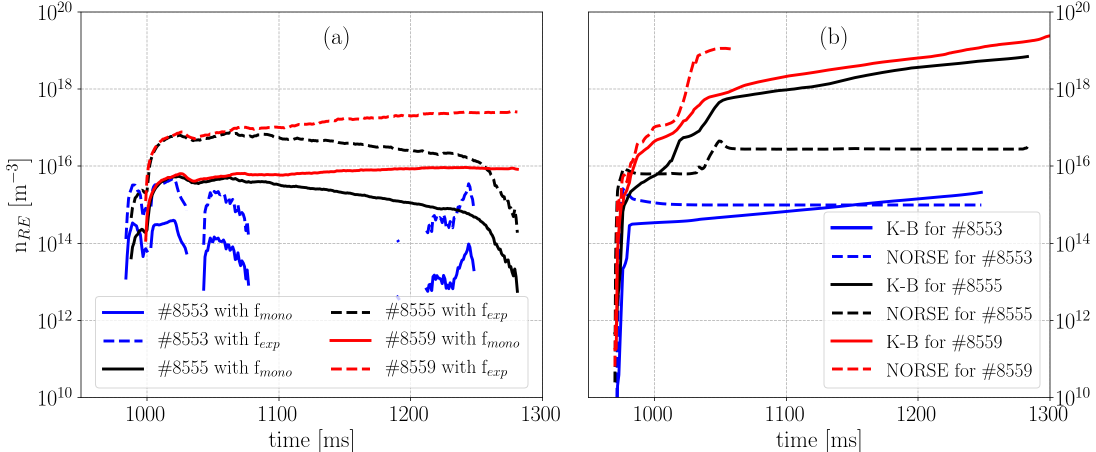
Figure 4. Time traces of the estimated n RE for the three typical discharges: #8553 (blue, standard discharge), #8555 (black, intermediate case) and #8559 (red, slide-away regime). ( a ) Estimates from measurements where for each discharge the two most extreme REDF: the monoenergetic f mono (full line) and the exponential f exp (dashed line). ( b ) Estimates from Kruskal–Bernstein theory (solid line) and NORSE simulation (dashed